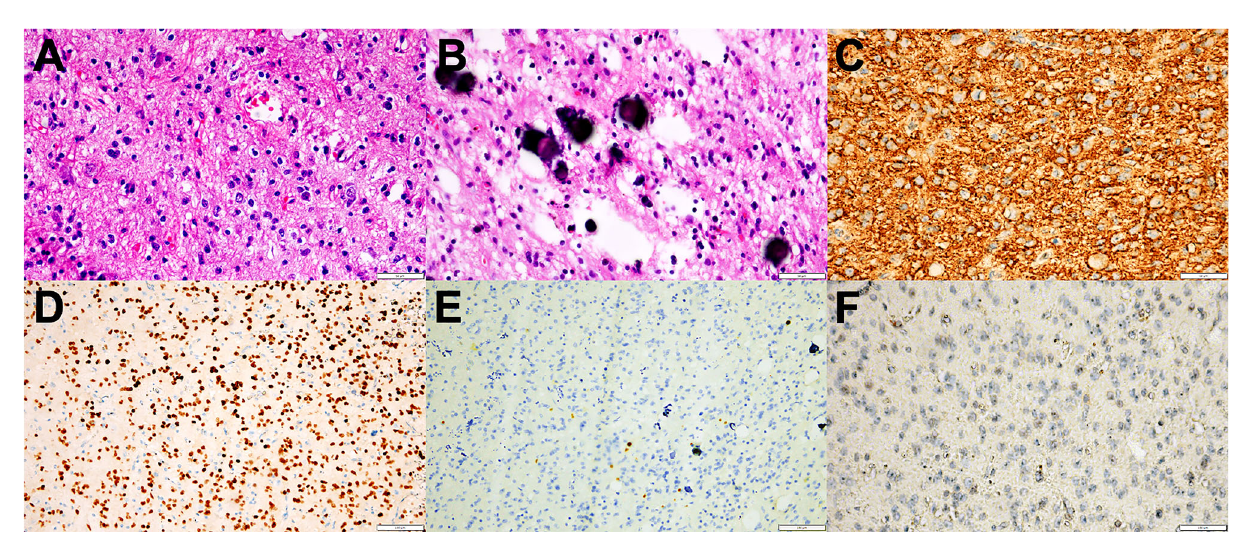
FIGURE 3 | Representative morphological and immunohistochemical features of PLNTY (Case c and d). (A) H&E staining images showing oligodendroglioma-like cellular components with round or oval nuclei, abundant thin-walled blood vessels between tumor cells, and absence of mitoses and necrosis. (B) Extensive calci fi cations were shown in H&E staining. (C) Strong and widespread expression of CD34 in tumor cells. (D) Olig-2 immunostaining was positive in all cases. (E) Ki-67 labeling was below 2%. (F) IDH1 mutation negativity was demonstrated.